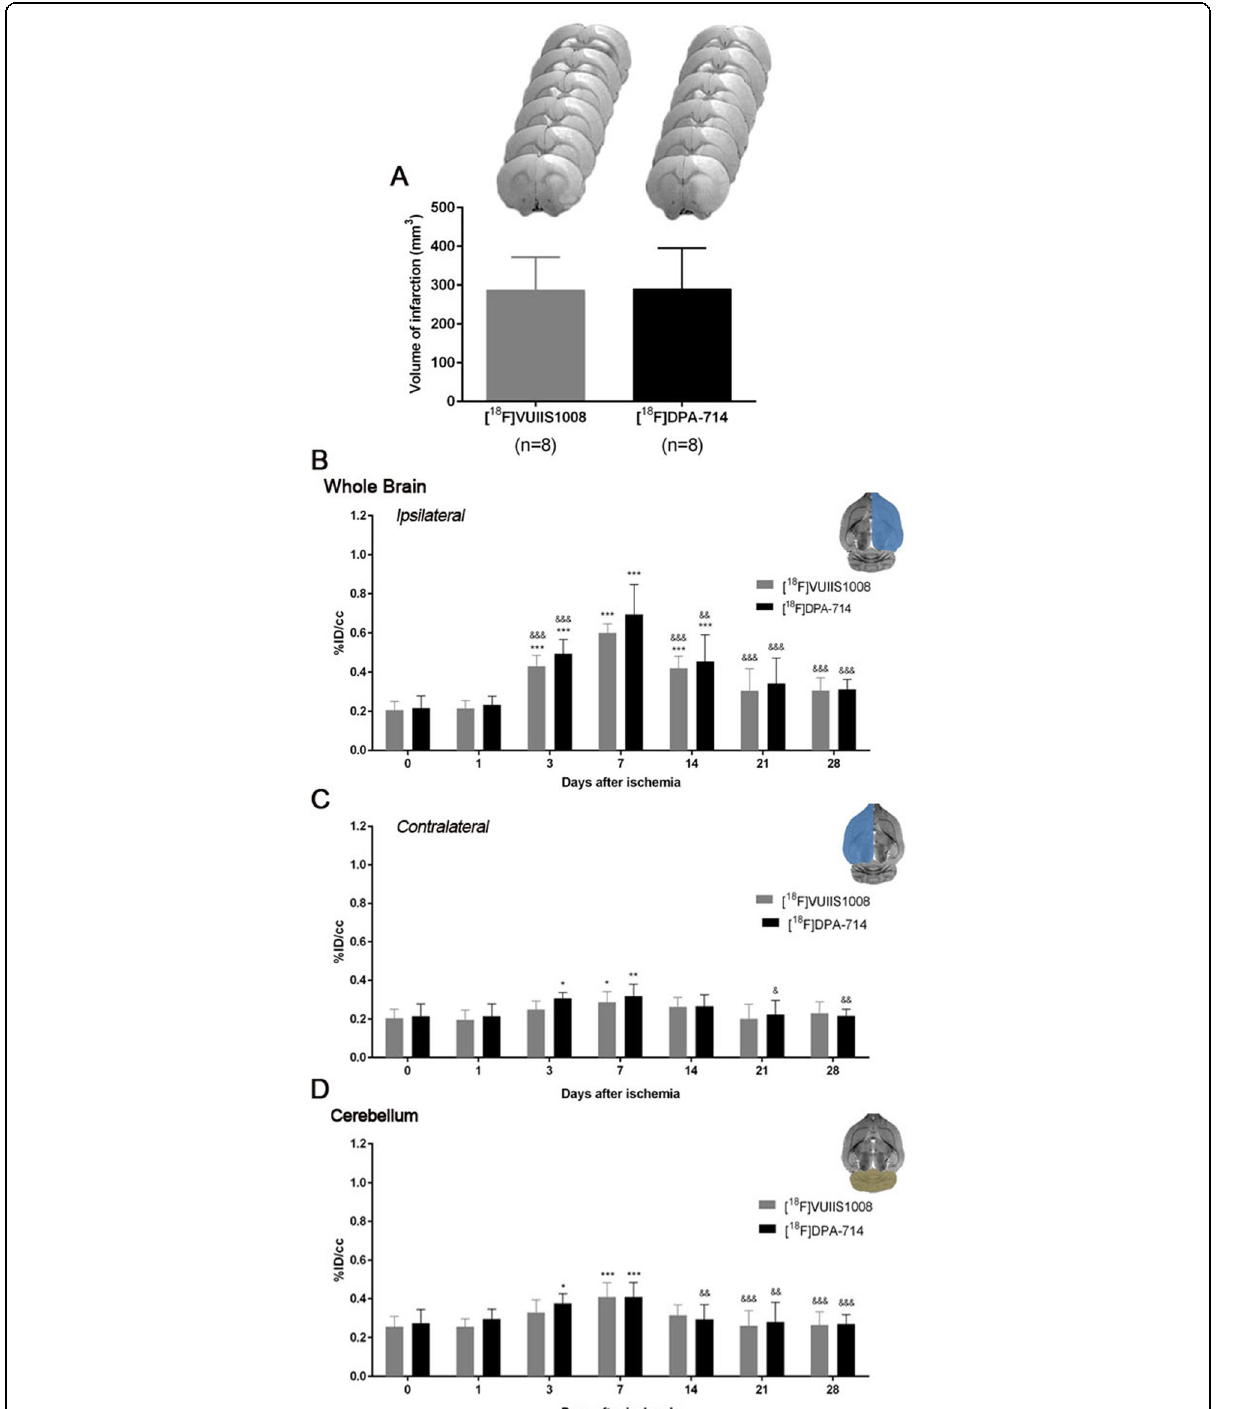
Fig. 2 Time course of the progression of the [ 18 F] VUIIS1008 and [ 18 F] DPA-714 PET signals before and after cerebral ischemia. The infarct size was determined by MRI at 24 h after MCAO ( a ). %ID/cm 3 (mean ± SD) of [ 18 F] VUIIS1008 and [ 18 F] DPA-714 was quantified in three VOIs. The entire ipsilateral cerebral hemisphere ( b ), contralateral hemisphere ( c ), and cerebellum ( d ) are shown. The upper right panels of each figure show the selected brain ROIs for the quantification defined on a slice of a MRI (T 2 W) template. Rats ( n = 8 per group) were repeatedly examined by PET before (day 0) and at 1, 3, 7, 14, 21, and 28 days after ischemia. * P < 0.05, ** P < 0.01, and *** P < 0.001 compared with control (day 0) and day 1; & P < 0.05, && P < 0.01, and &&& p < 0.001 compared with day